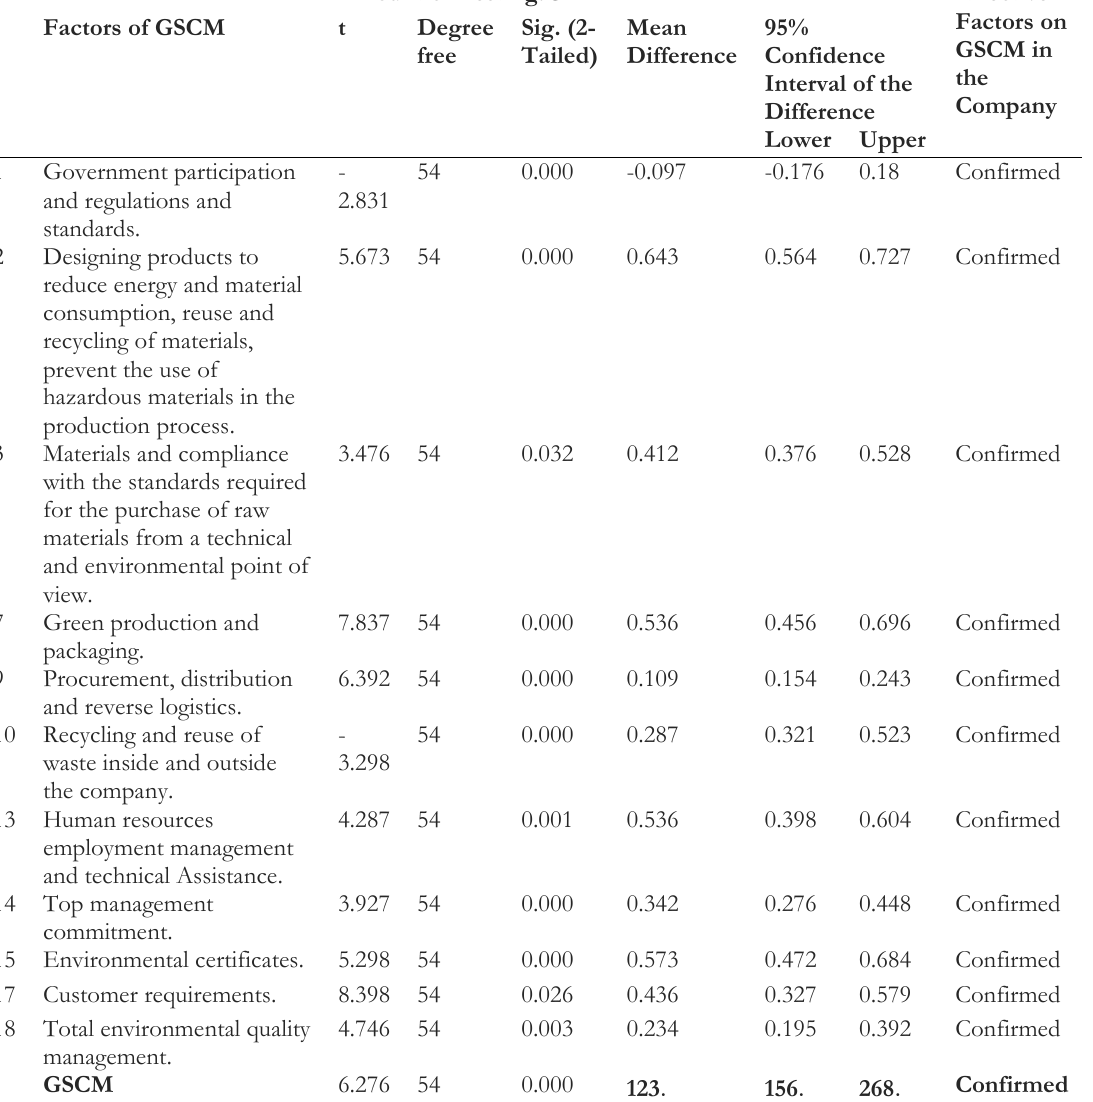
Table 3. Effective Factors on GSCM in the company.